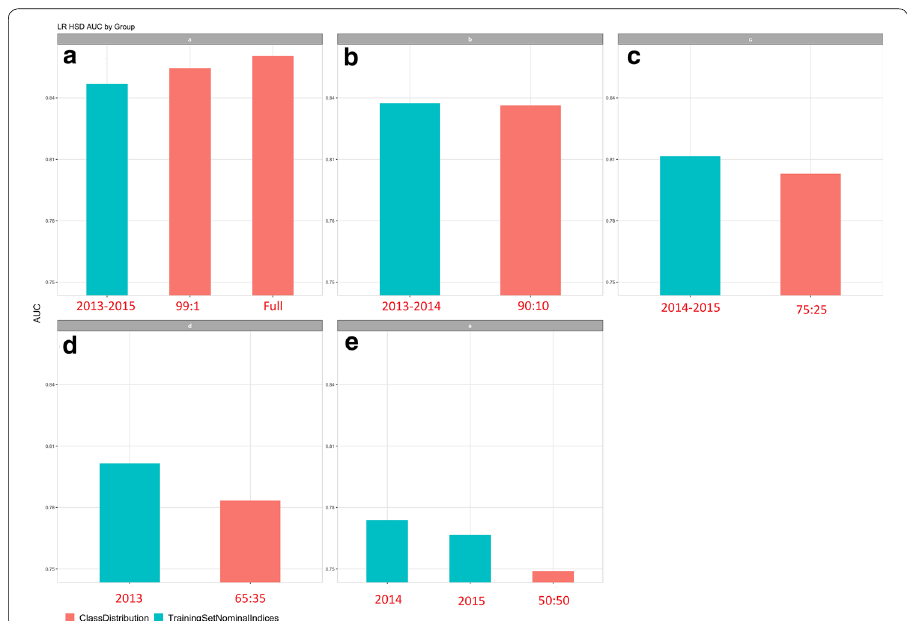
Fig. 7 Logistic Regression HSD plots